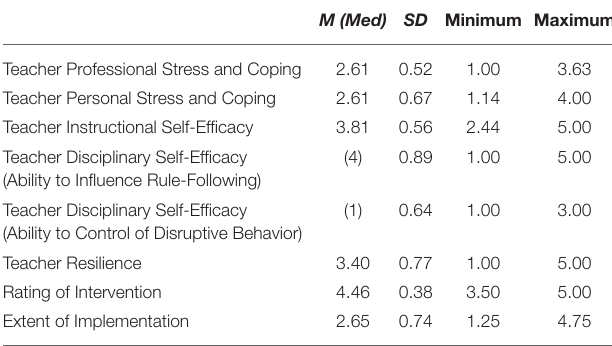
TABLE 1 | Mean, median, standard deviation, and range of study